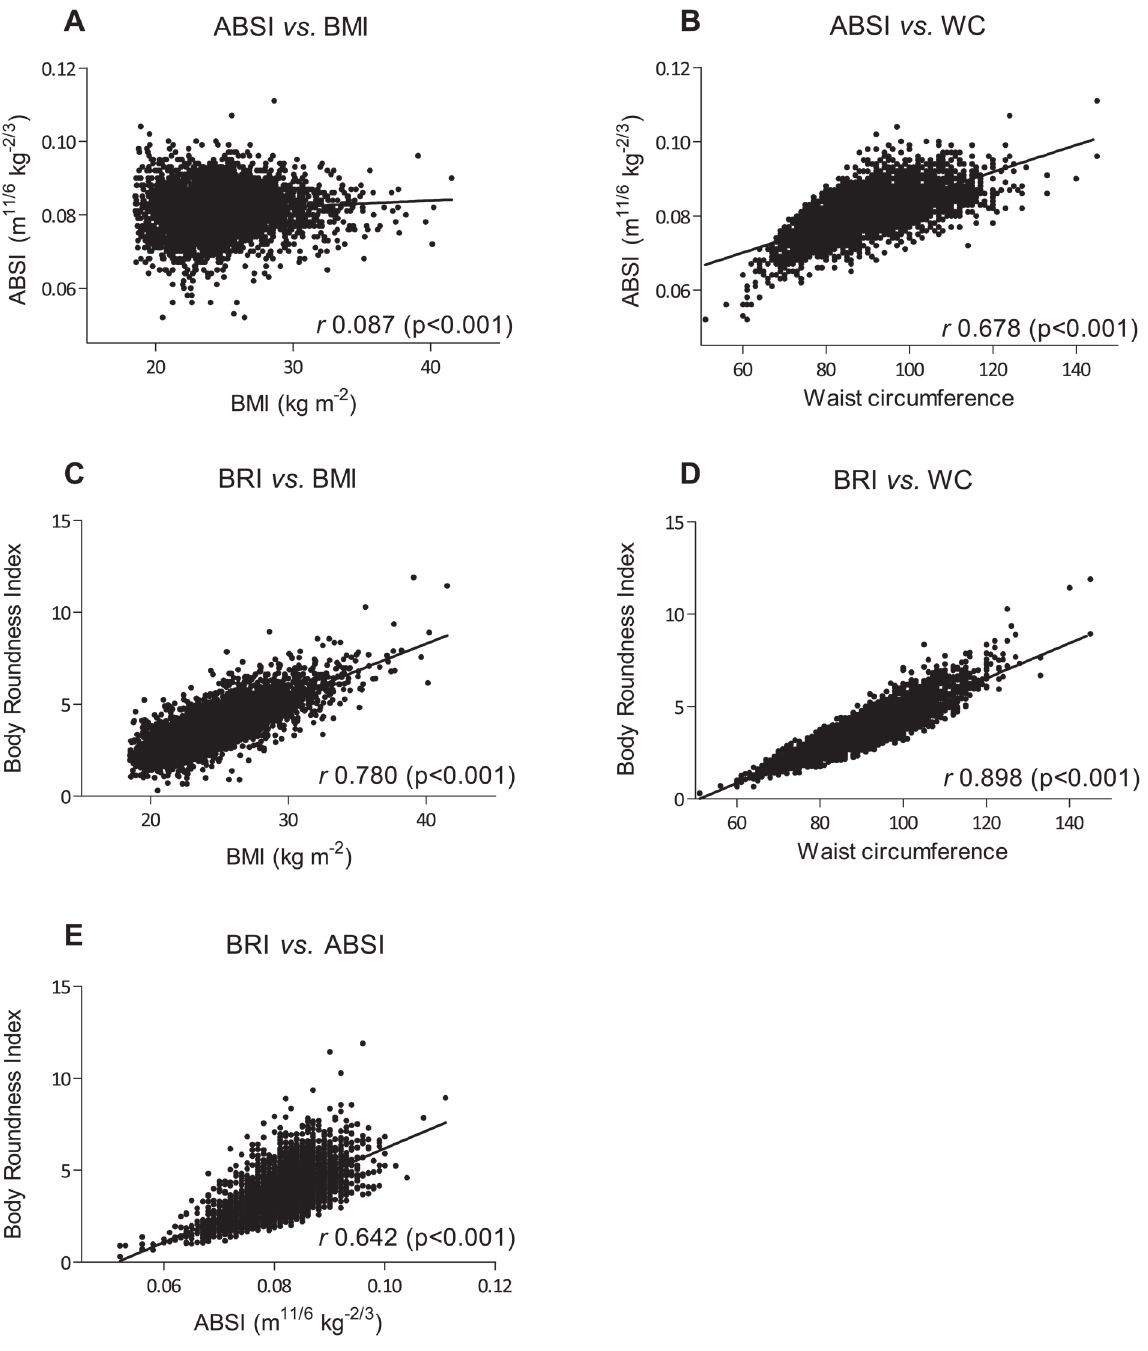
Figure 2. Correlations between ABSI, BMI, BRI, and WC. A. Correlation between ABSI and BMI. Increase in ABSI and increase in BMI show a poor yet significant correlation ( r =0.087, P , 0.001). B. Correlation between ABSI and WC. Increase in ABSI and increase in WC show a significant correlation ( r =0.678, P , 0.001). C. Correlation between BRI and BMI. Increase in BRI and increase in BMI show a significant correlation ( r =0.780, P , 0.001). D. Correlation between BRI and WC. Increase in BRI and increase in WC show a significant correlation ( r= 0.898, P , 0.001). E. Correlation between BRI and ABSI. Increase in BRI and increase in ABSI show a significant correlation ( r= 0.642, P , 0.001).